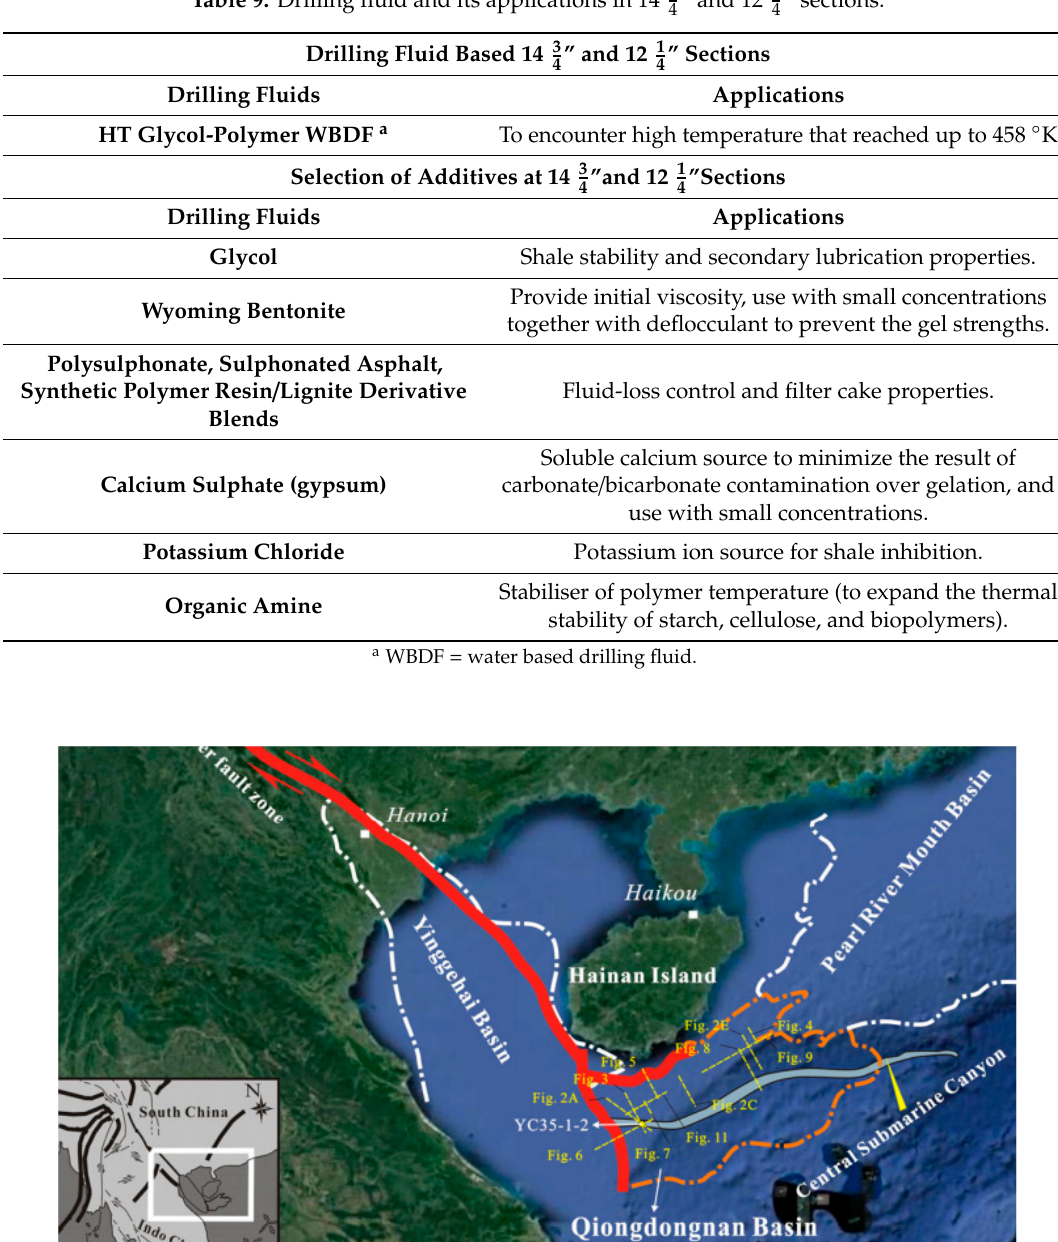
Table 8. An overview of HPHT unconventional reservoir challenges and research gaps.